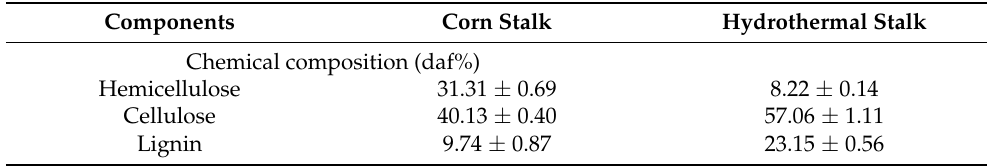
Table 1. Characteristics of corn stalk and hydrothermal stalk.